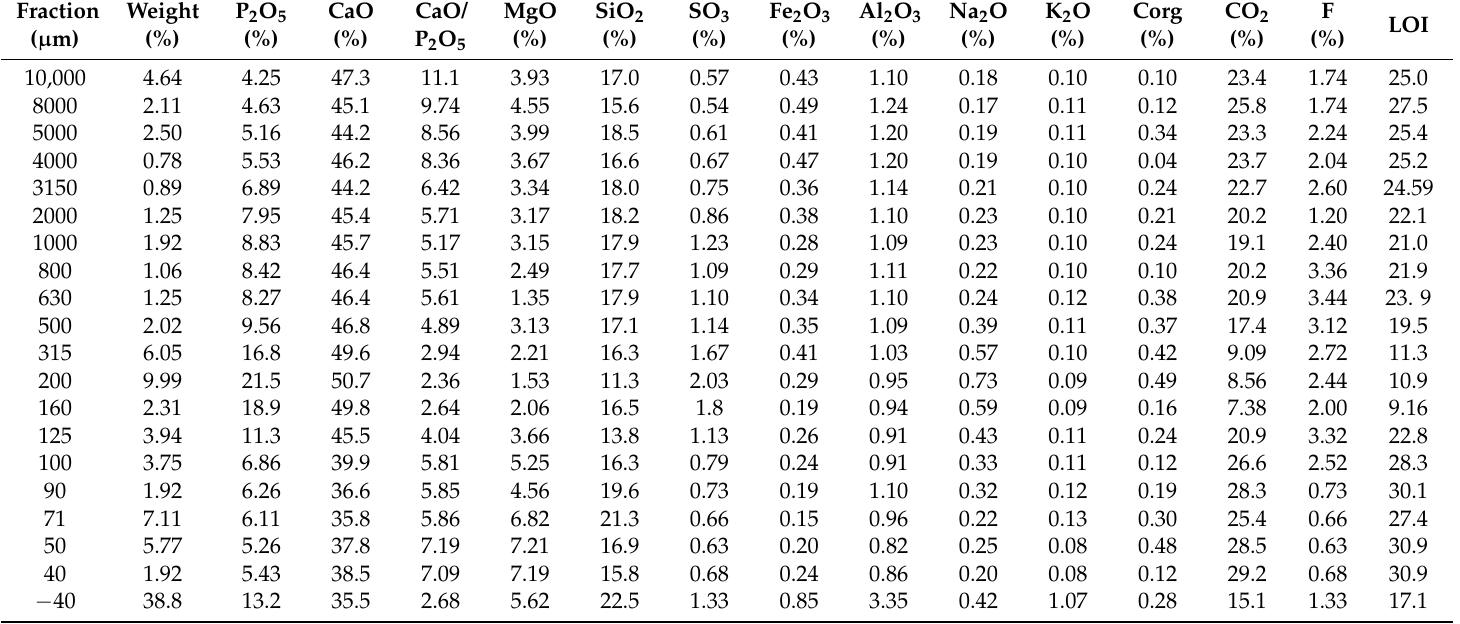
Table 3. Chemical results of major elements in different size fractions of the studied raw